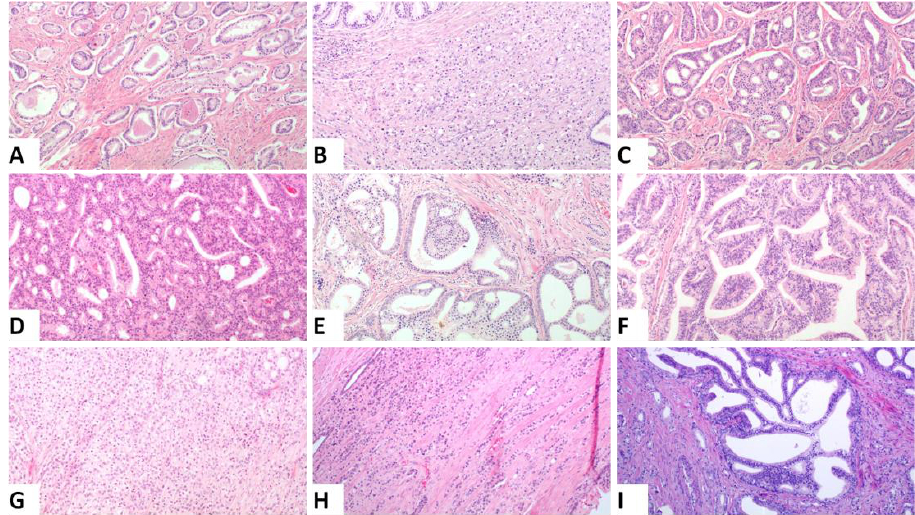
Figure 1. Representative histologic images from the different patterns that were assessed, ( A ). Single glands corresponding to Gleason pattern 3, ( B ). Poorly formed and fused glands, ( C ). Small cribriform formations, ( D ). Large cribriform formations (original magnification × 100), ( E ). Glomeruloid pattern, ( F ). Papillary pattern Images ( B – E ) correspond to Gleason pattern 4, ( G ). Solid nests, ( H ). Single cells and cords, Images ( G , H ) correspond to Gleason pattern 5, ( I ). Intraductal carcinoma: (( A , B , D , E , G , H , I ): original magnification × 100; ( C ): original magnification × 40; ( F ): original magnification × 200).